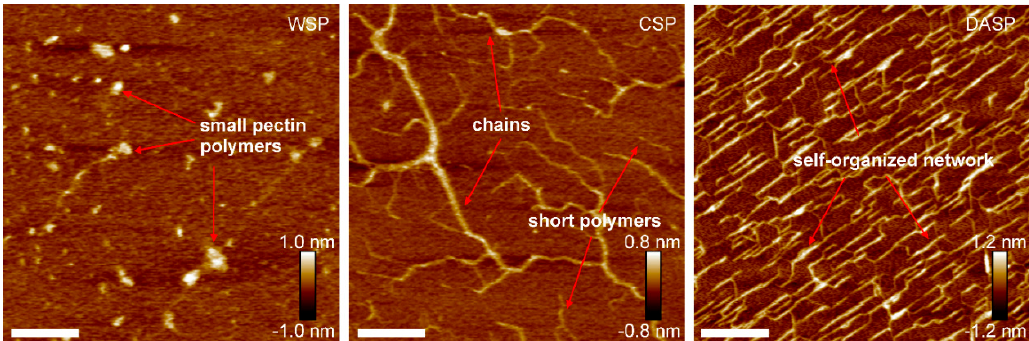
Figure 2. AFM images of water-soluble pectin (WSP), chelator-soluble pectin (CSP), and diluted alkali-soluble pectin (DASP) fractions obtained from apples (cultivar Idared); white bar indicates 200 nm.